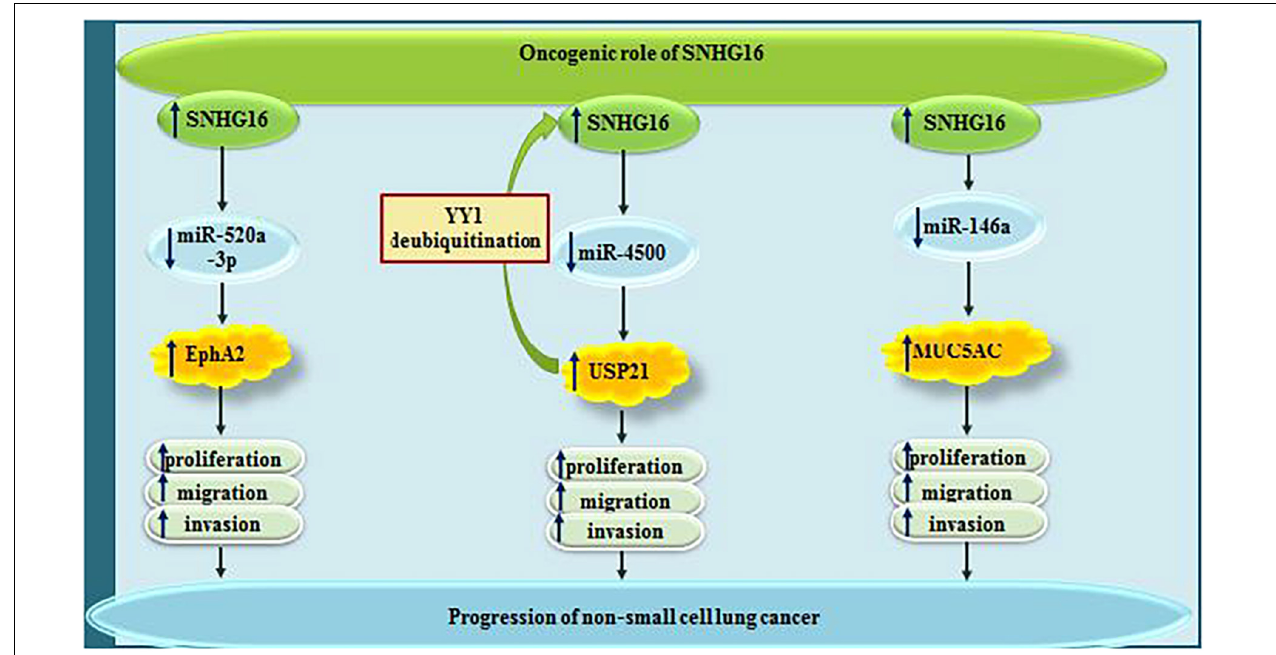
FIGURE 1 | The oncogenic roles of SNHG16 in lung cancer are mainly mediated through sponging miR-520a-3p, miR-4500, and miR-146a.